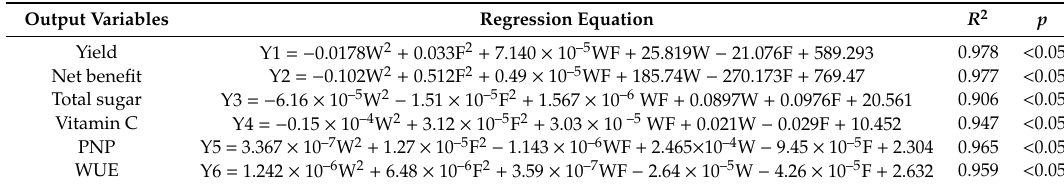
Table 6. Regression model of water and fertilizer input and jujube yield, economic benefit, quality, partial factor productivity (PNP), and water use efficiency (WUE).